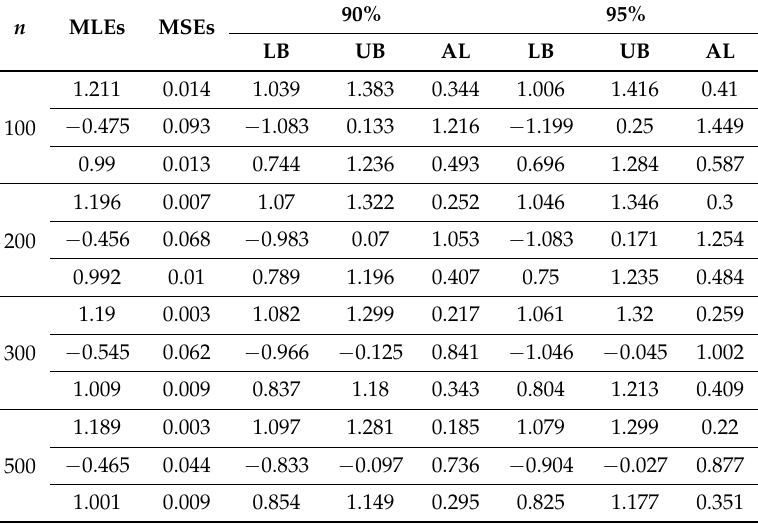
Table 5. Numerical measures of interest of the TOFrE model for Set3 (1.2, − 0.5, 1).